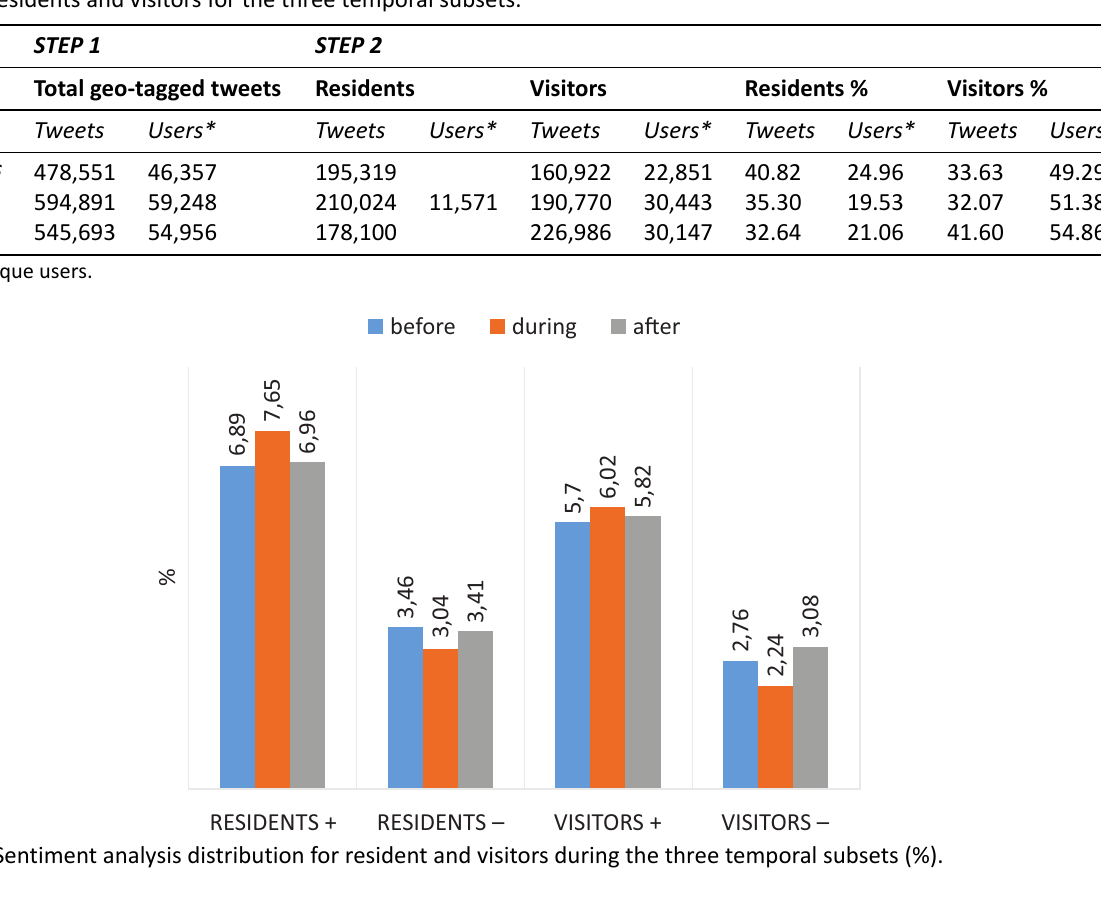
Table 2. Residents and visitors for the three temporal subsets.